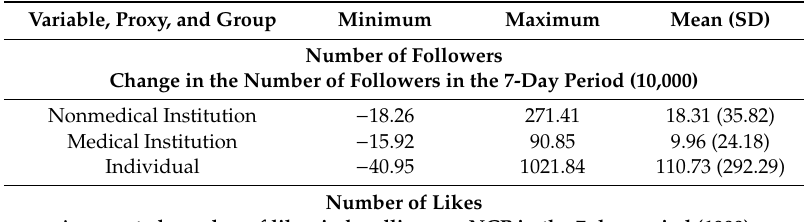
Table 3. Items and statistical